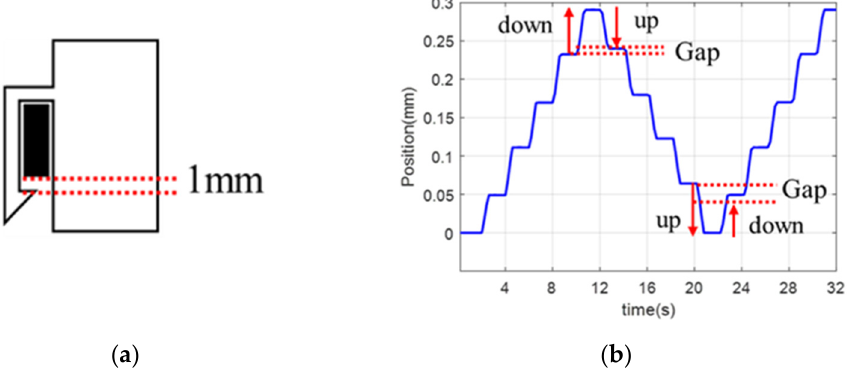
Figure 7. Characteristics of the roller cartridge. ( a ) Gap between the roller cartridge and the bar of the roller module. ( b ) Position of the roller cartridge by pre-compensated